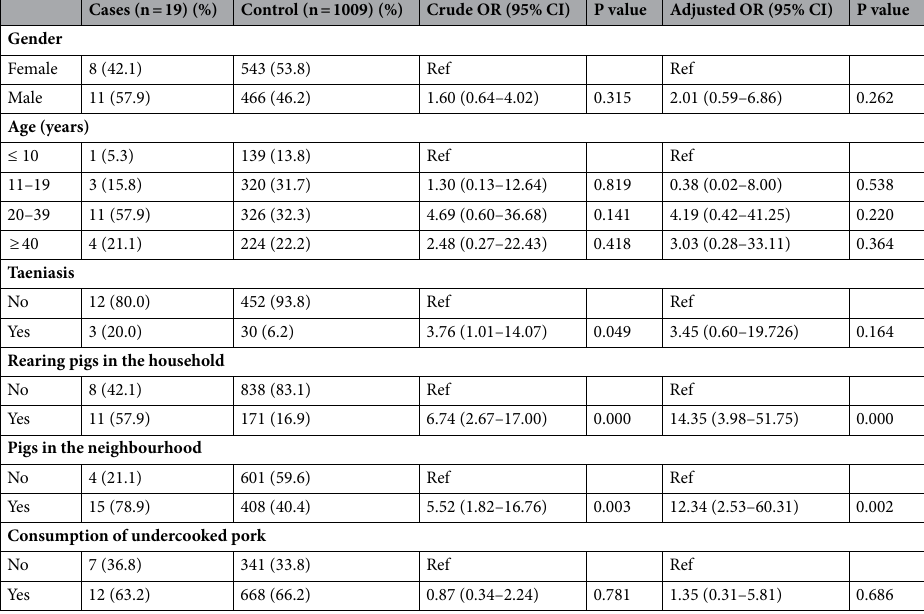
Table 5. Predictors of neurocysticercosis in the tea garden community of Assam, Northeast India. Model adjusted for all variables included in the table. Controls were apparently healthy individuals from the community. OR odds ratio, CI confidence interval, Ref reference